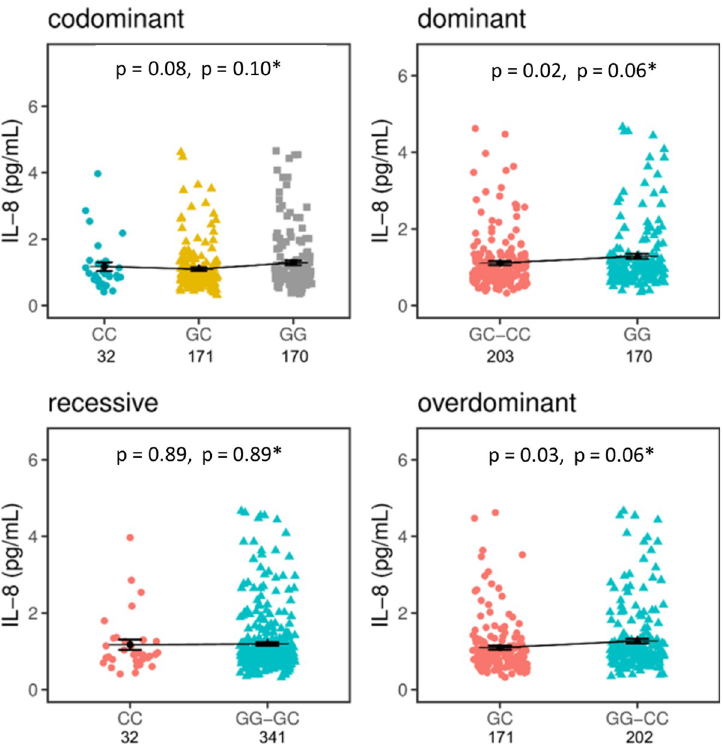
Fig 1. MIRNA146A rs2910164 effects on IL-8 plasma levels in healthy controls. Concentrations of plasma circulating IL-8 were compared between bearers of the AA, AG, and GG genotypes using inheritance models (codominant, dominant, recessive and overdominant). The mean concentrations are displayed in picogram per millilitre (pg/mL) with standard error (SE) of mean. The means are represented by black bars, whereas SE are represented by error bars. � Corrected for Benjamini-Hochberg False Discovery Rate assuming four tests. p < 0.05 is statistically significant.